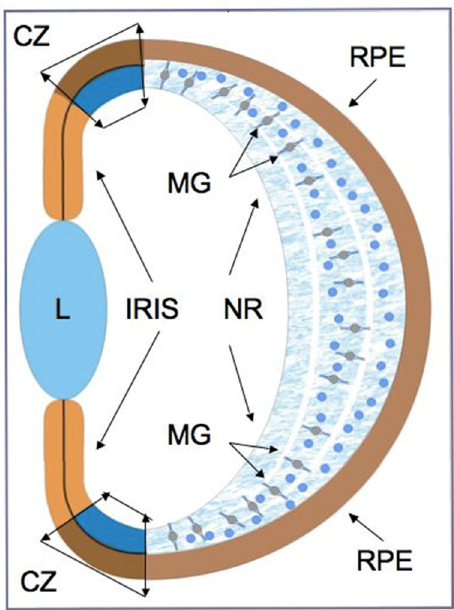
Figure 1. Schematic diagram of retinal regeneration cell sources (RRCS)s’ locations in the eye of adult vertebrates (summarized data). RPE—retinal pigment epithelium cells (latent differentiated); NR—neural retina; MG—Müller glial cells (latent differentiated); Iris cells (latent differentiated); CZ—eye ciliary zone: ciliary marginal zone (CMZ) in low vertebrates (stem cells and low differentiated precursors) and ciliary body (difined CB cells in mammals (latent differentiated); L—lens.